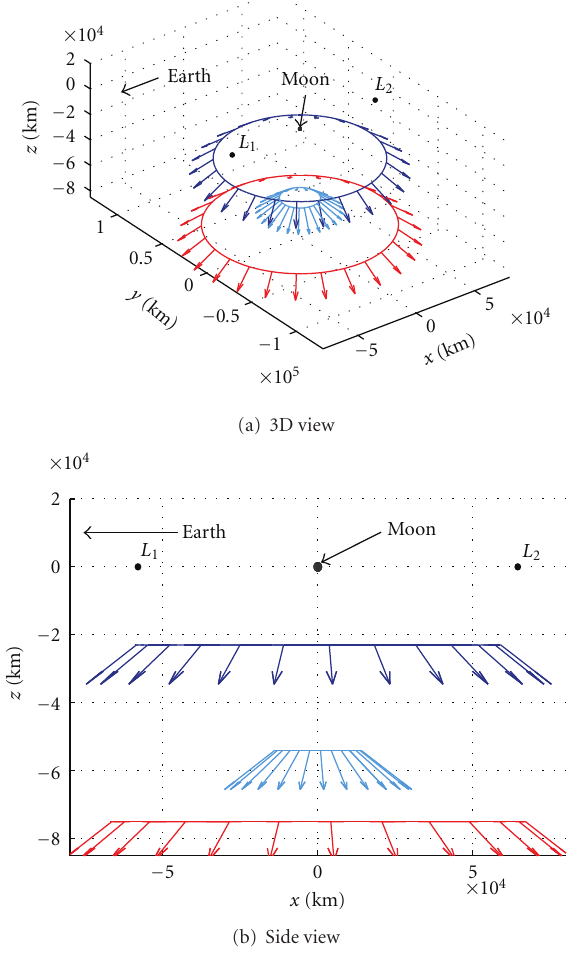
Figure 4: Three example initial guesses. Figure 5: Three converged orbits from the FDM-R process.